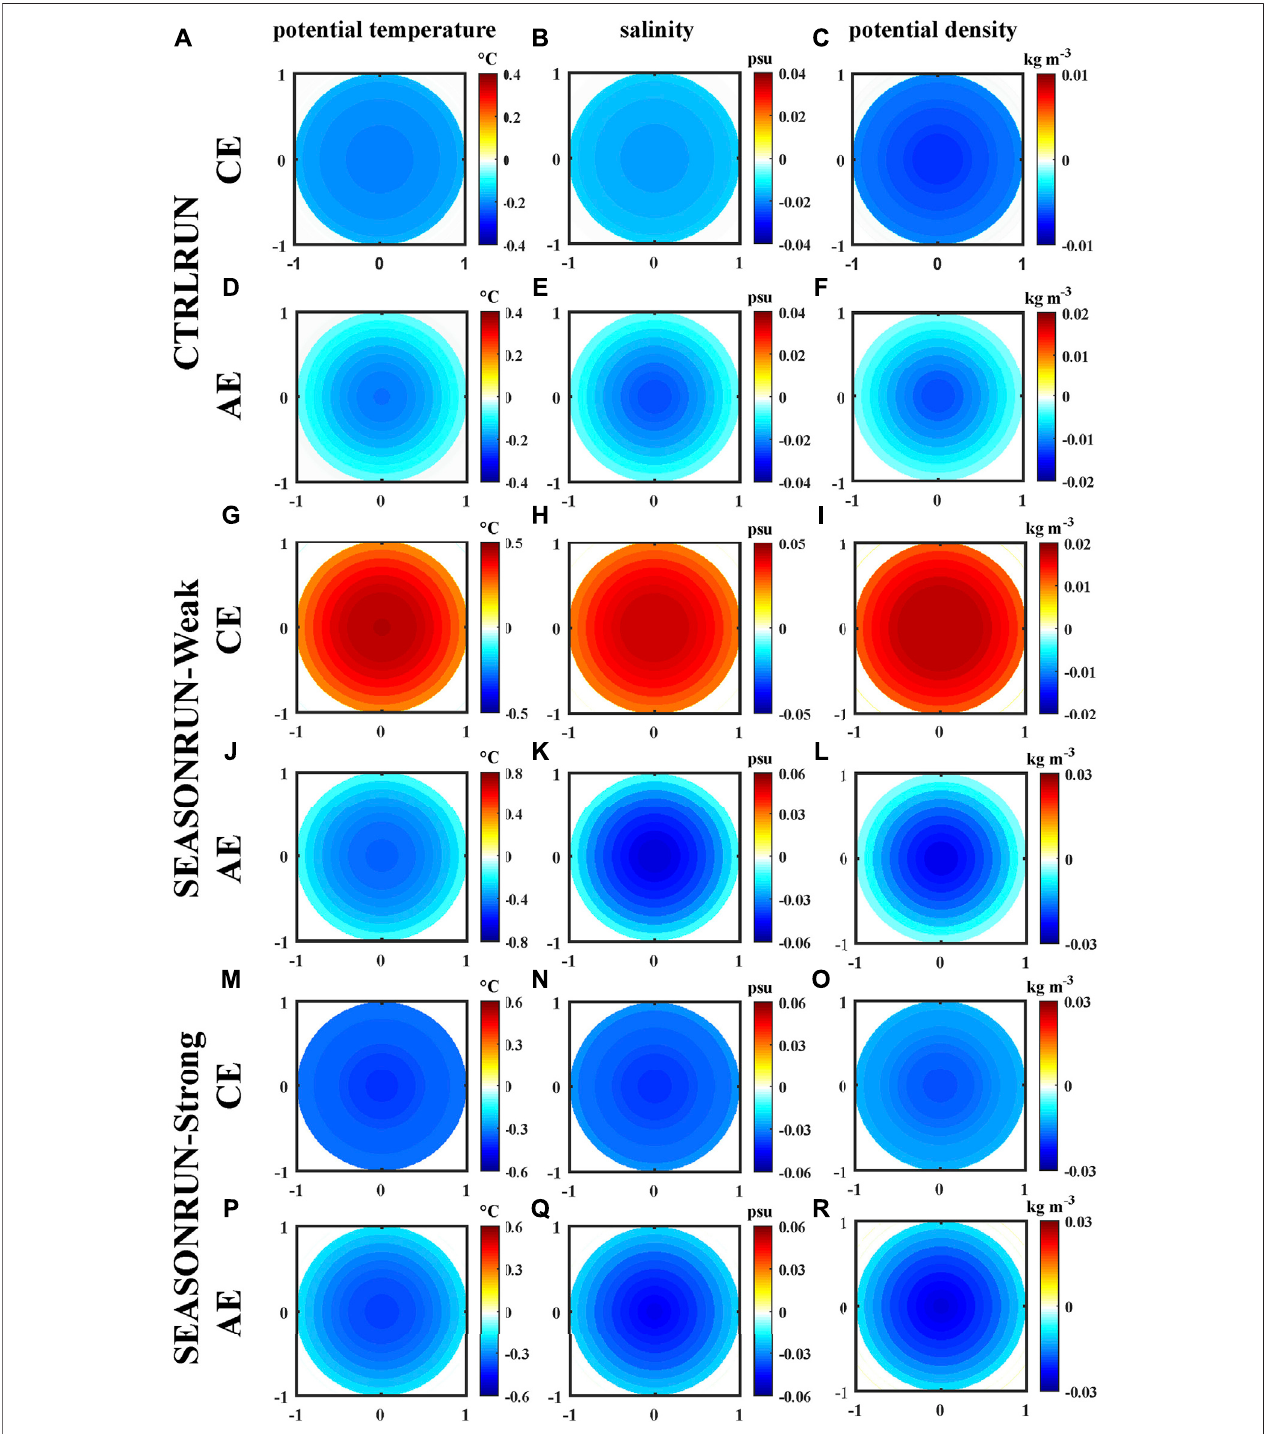
FIGURE 8 | (A) The averaged values of potential temperature anomalies ( ° C) along a set of concentric circles around the composite eddy center of CE at 200 m depth intheCTRLRUN. (B) Same as (A) ,but forthesalinity anomalies(psu). (C) Same as (A) ,but forthepotentialdensity anomalies(kgm − 3 ). (D – F) Same as (A – C) ,but forthecompositeeddyofAEat100 mdepth. (G – L) Sameas (A – F) ,butforthecompositeeddiesat100 mdepthintheSEASONRUN-Weak. (M – R) Sameas (A – F) ,but for the composite eddies in the SEASONRUN- Strong.